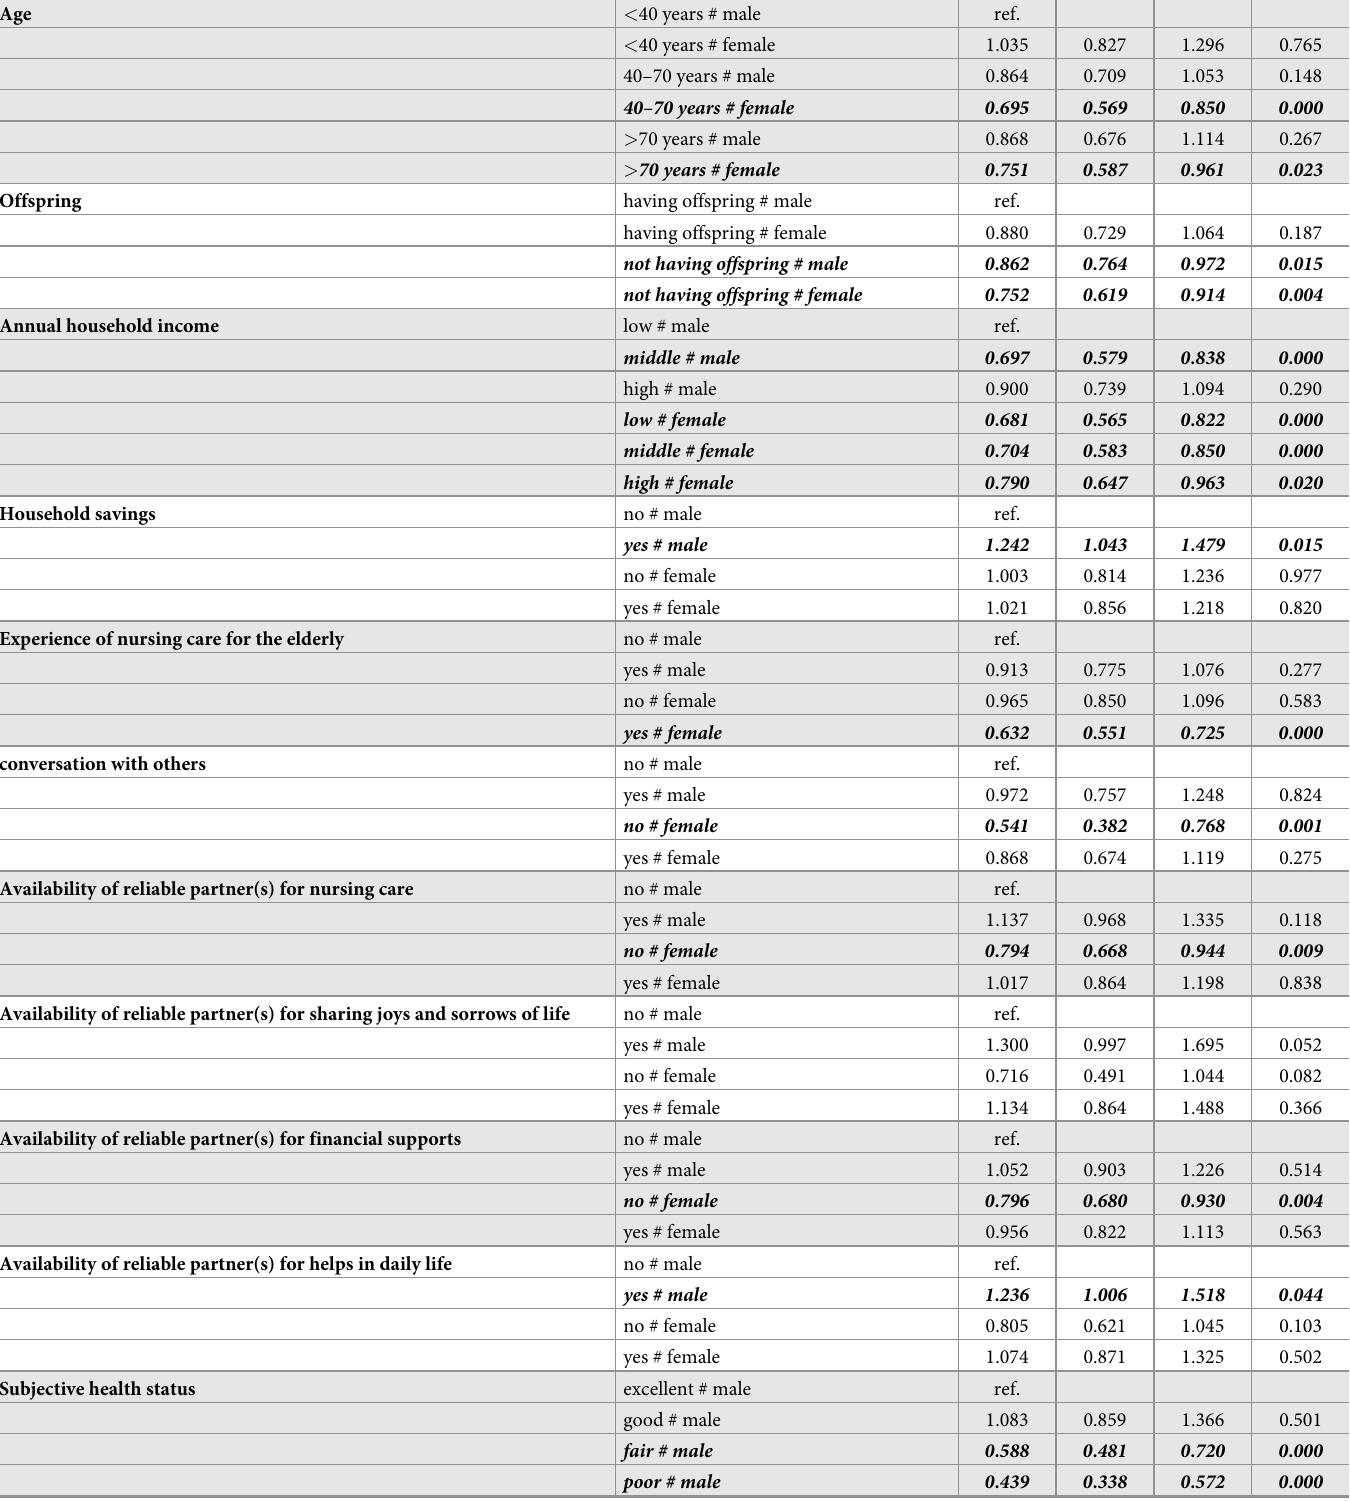
Table 5. Interactions of major factors and